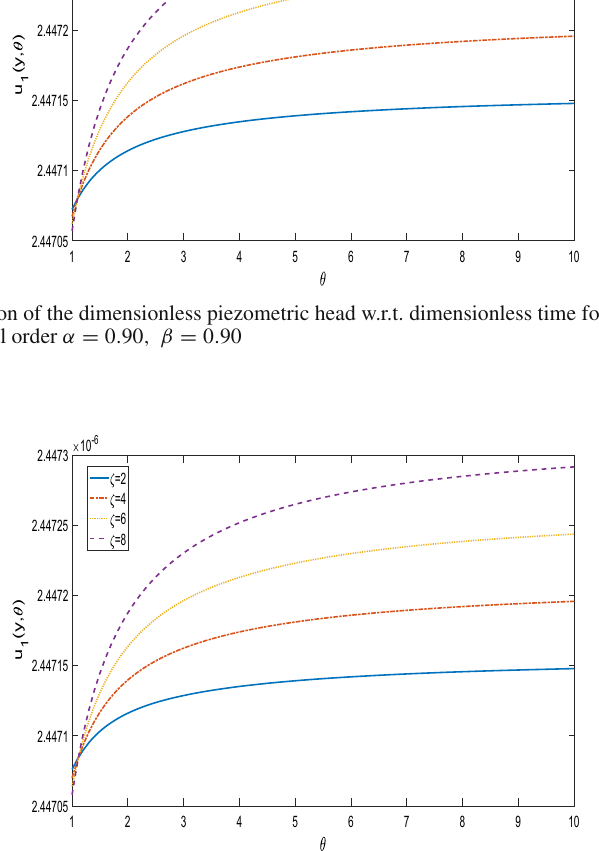
Fig. 3 Graphical representation of the dimensionless piezometric head w.r.t. dimensionless time for η = 10, and ζ = 2, 4, 6, 8 at distance y = 5.5 and fractional order α = 0 . 90 , β = 0 .